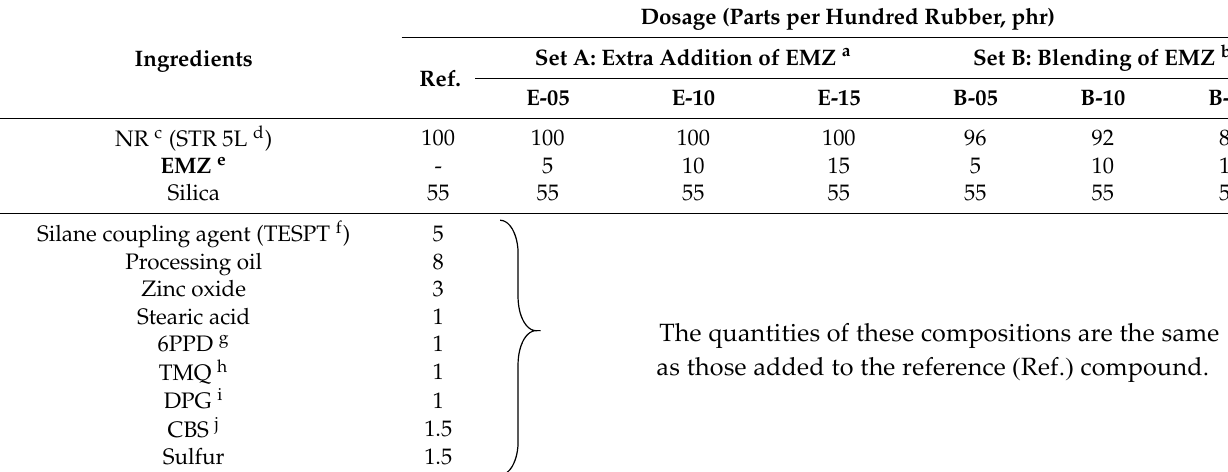
Table 1. Compound formulations used in this study.